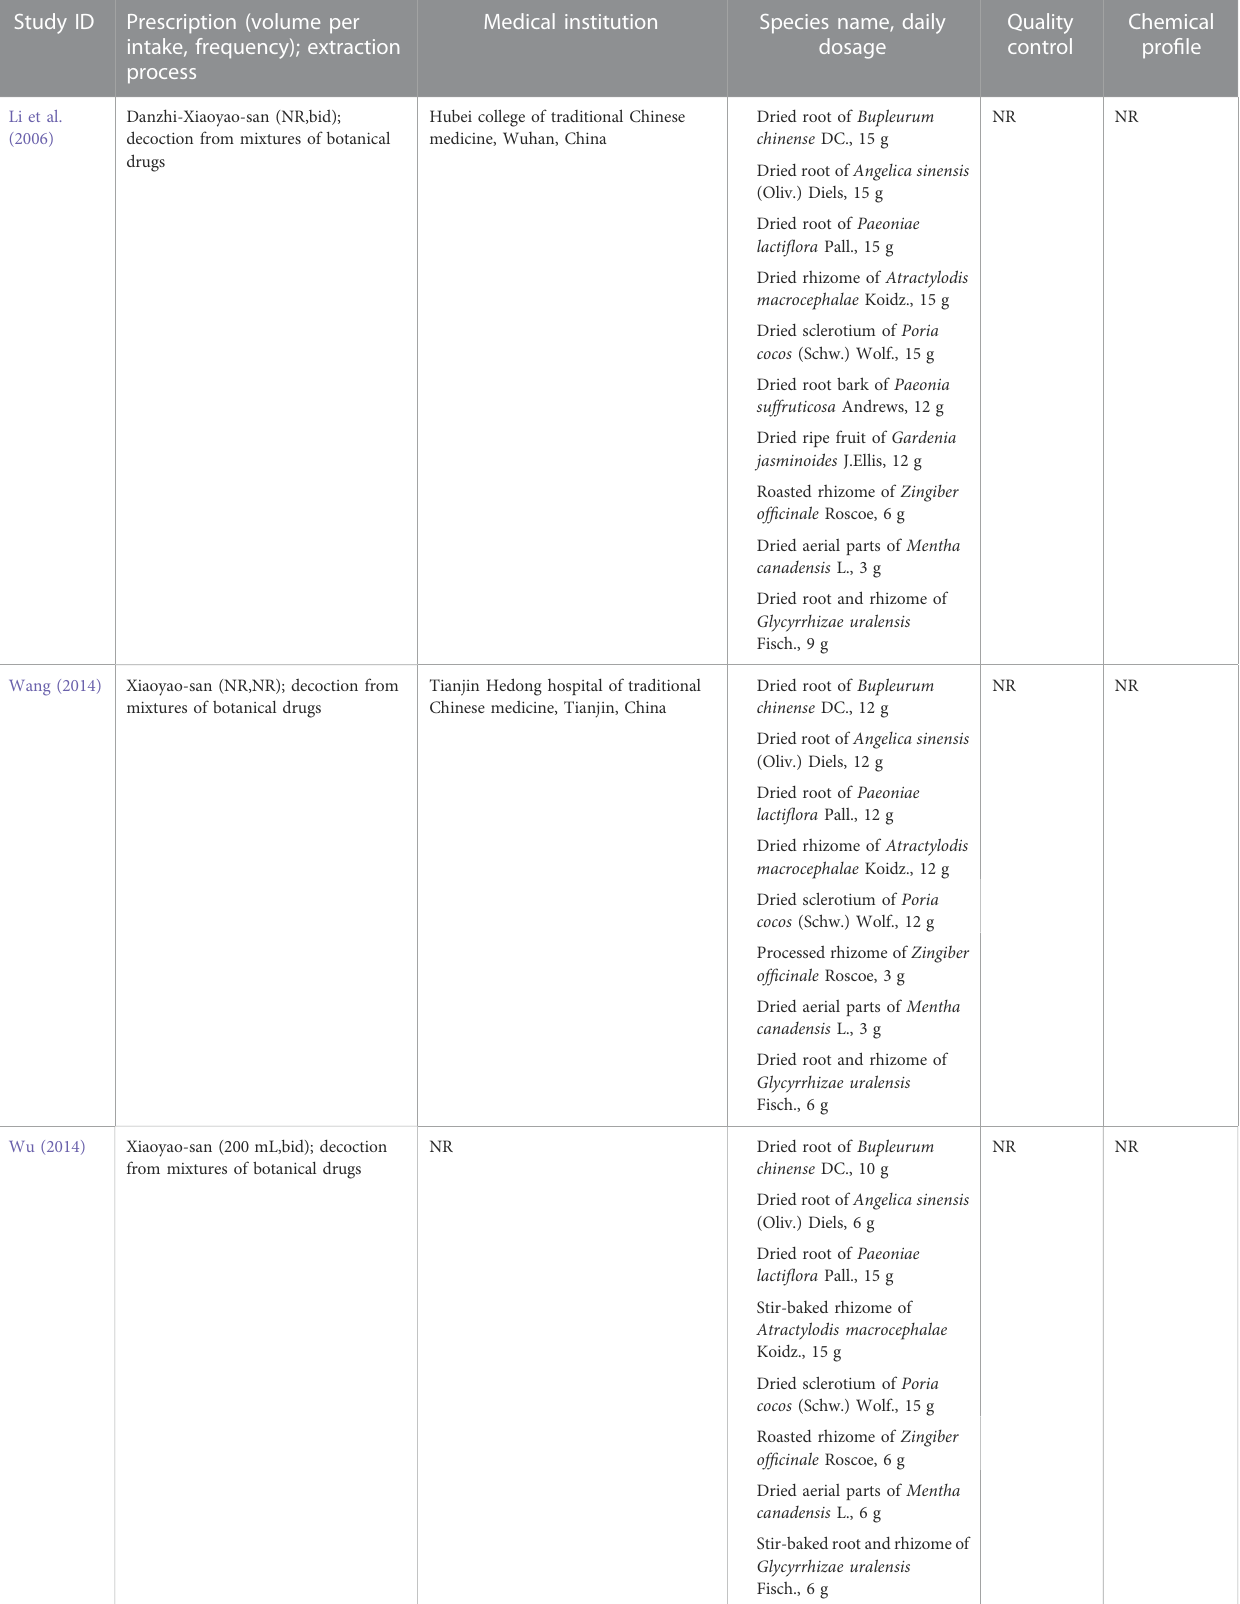
TABLE 3 Herbal prescription and its components in the included